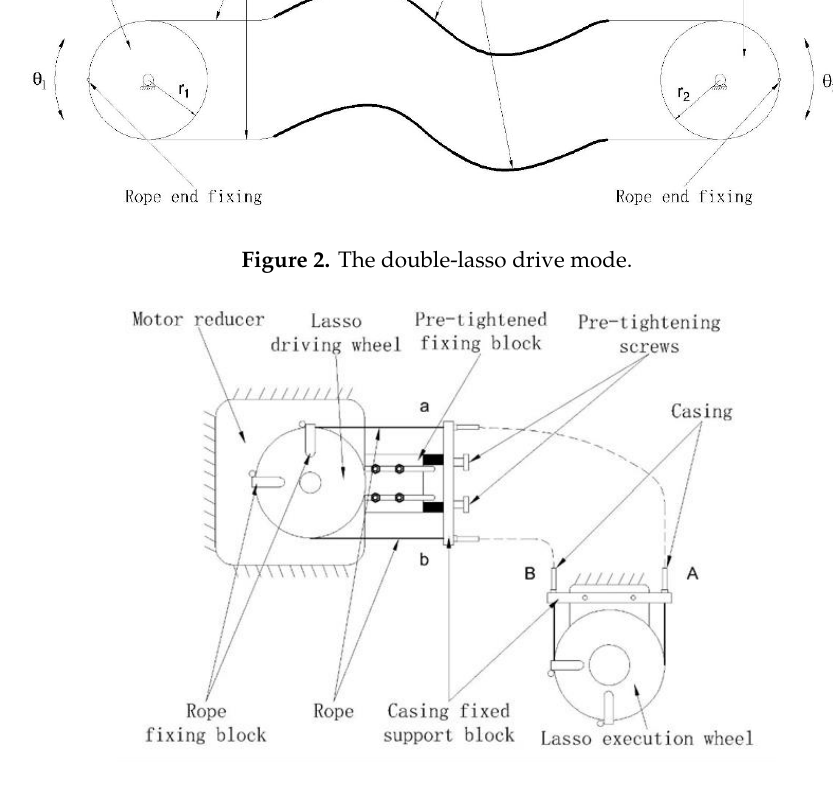
Figure 3. Schematic diagram of the double-lasso drive system. Table 1. Comparison of robotic devices for upper limb rehabilitation.